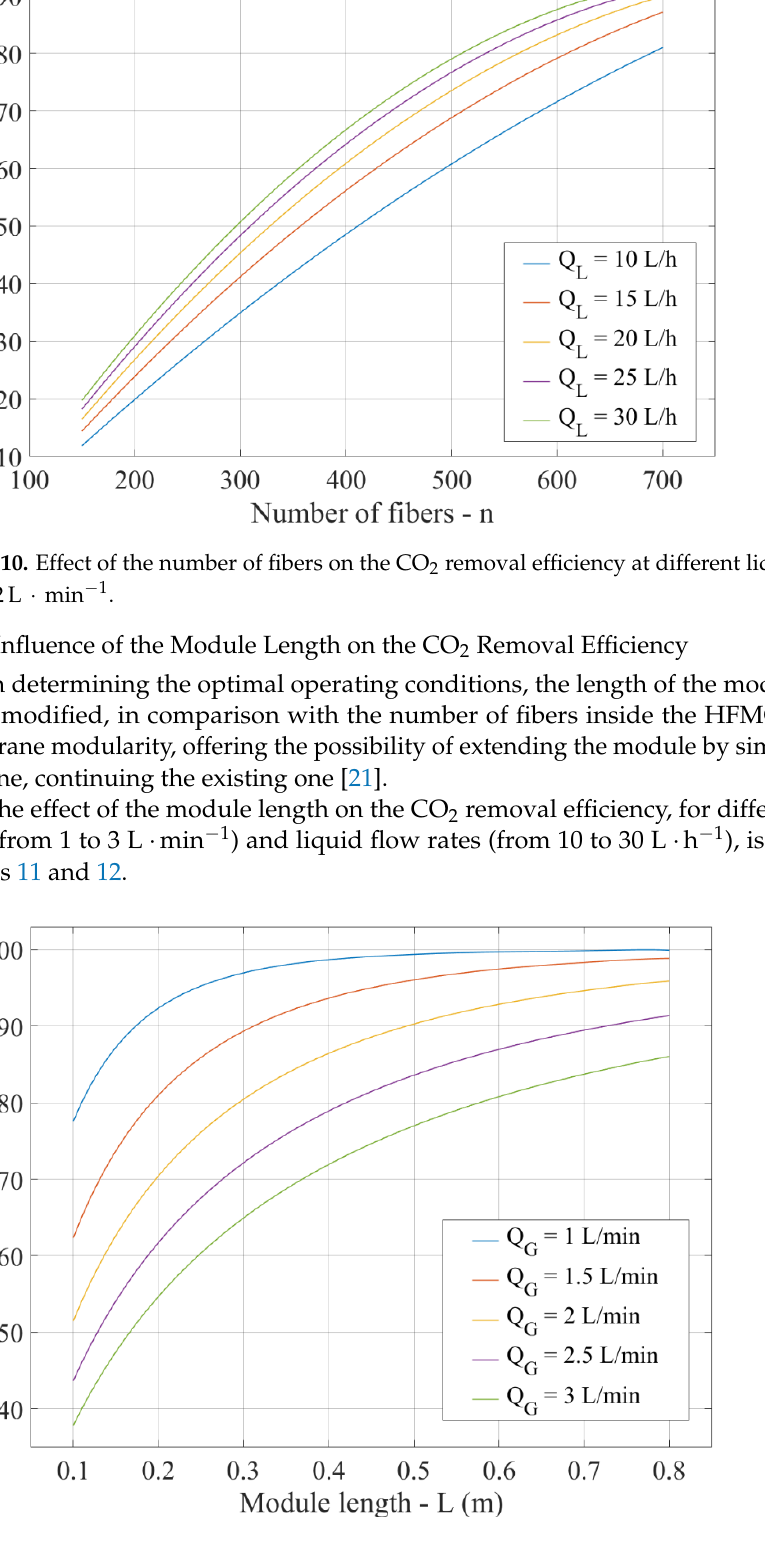
Figure 9. Effect of the number of fibers on the CO 2 removal efficiency at different gas flow rates, 1